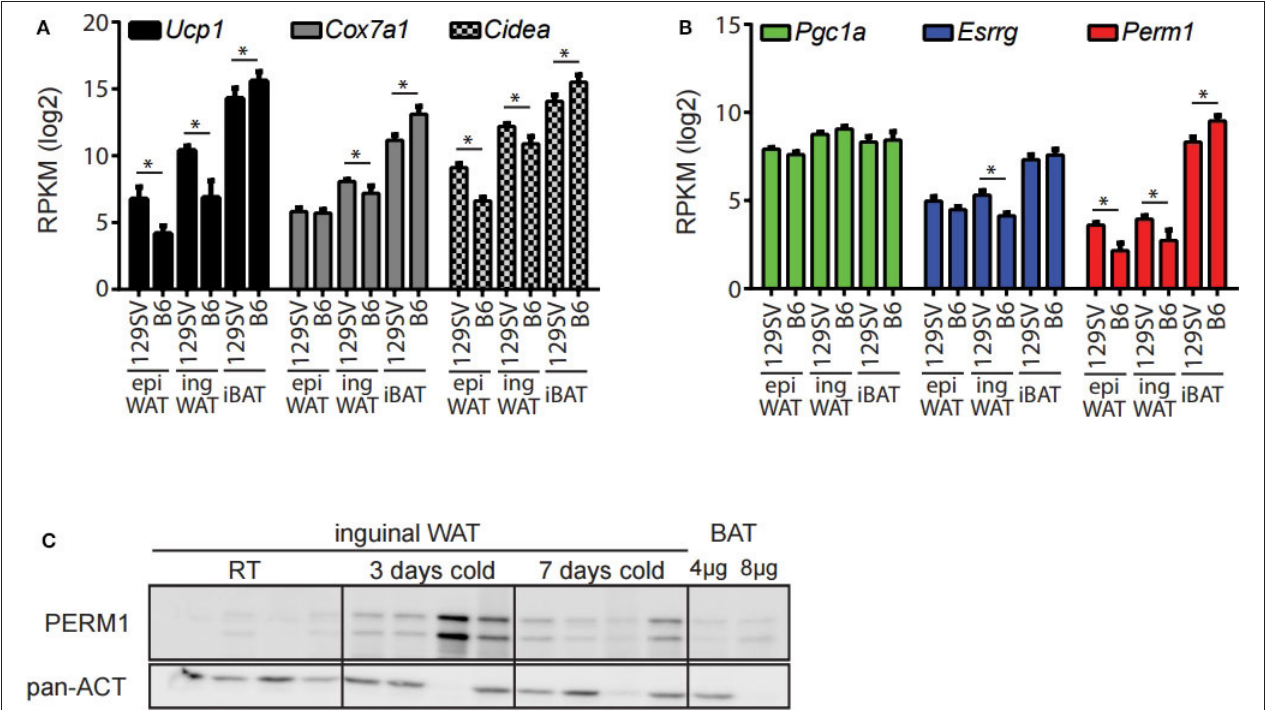
FIGURE 2 | Esrrg and Perm1 mirror thermogenic capacity in adipocyte fractions of 129/SV and C57BL/6 mouse models. (A) Expression of common browning markers Ucp1 , Cox7a1, and Cidea in the adipocyte fractions of epiWA, ingWA, and iBA in 129/SV or C57BL/6 mice housed at room temperature. Data are presented as mean RPKM with SEM ( n = 4). (B) Expression of Pgc1 α , Esrrg, and Perm1 in the adipocyte fractions of epiWA, ingWA and iBA in 129/SV or C57BL/6 mice housed at room temperature. Data are presented as mean RPKM with SEM ( n = 4). (C) PERM1 and UCP1 protein levels in ingWAT of 129/SV mice at room temperature and after 3 and 7 days of cold exposure. BAT at 1/10 and 1/5 of protein loaded shown for comparison. Each lane represents a single mouse ( n = 4). Statistical testing ( t -test) was performed between the mouse strains (129SV & B6) in each of the different tissue derived adipocyte fractions. A statistically significant result, meaning p- value < 0.05, is indicated with an asterisk